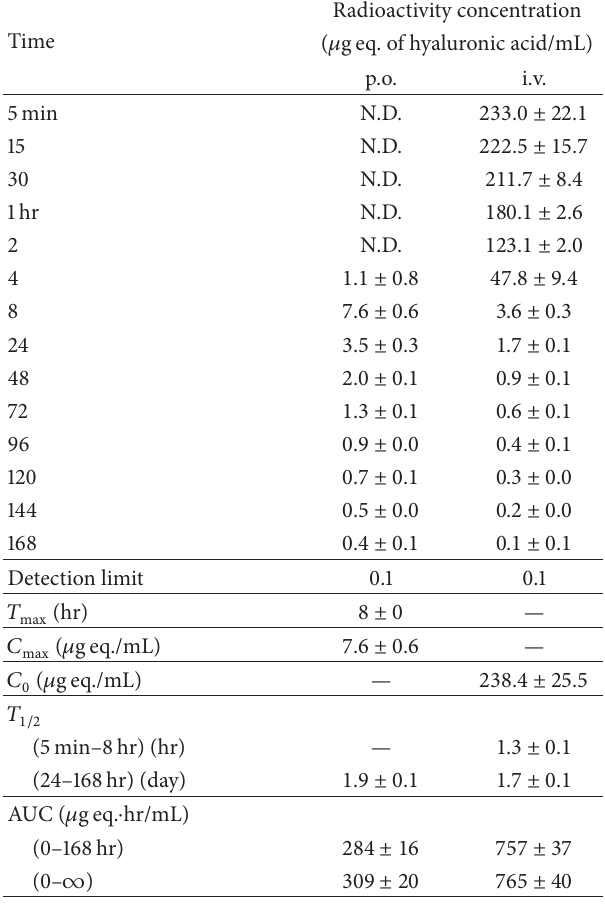
Table 1: Radioactivity concentration in plasma after single oral or intravenous administration of 14 C hyaluronic acid to rats (dose: p.o.; 25 mg/kg, IV; 10